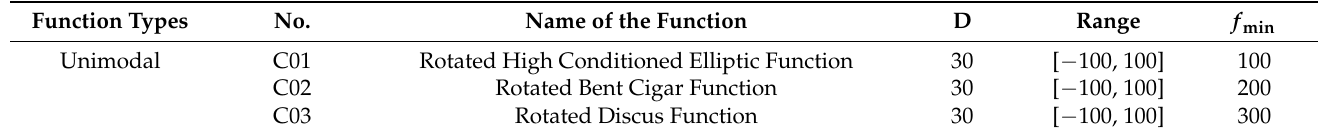
Table 1. CEC 2014 benchmark